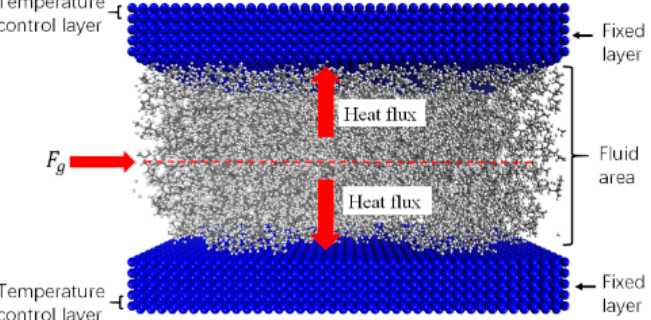
Figure 10. Polymer flow heat transfer model.